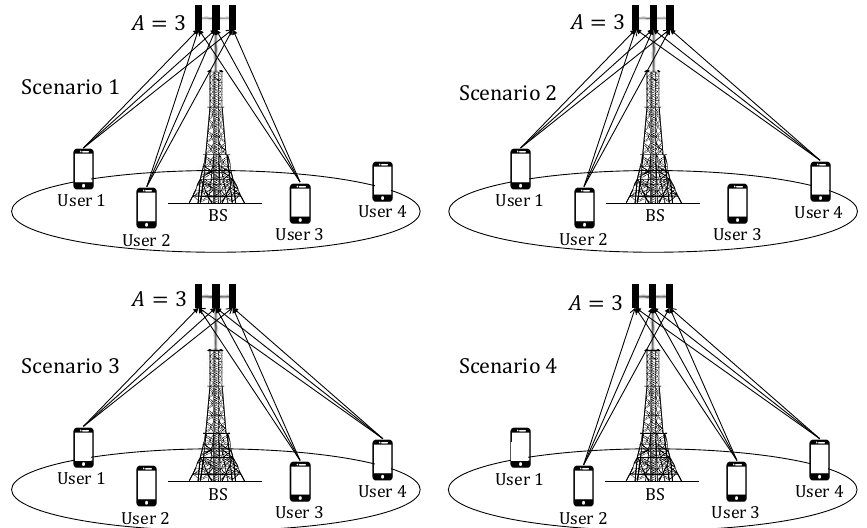
Figure 2. Channel assignment scenarios with the proposed scheduling scheme considering U t = 4 and U = 3 for A = 3 receiving